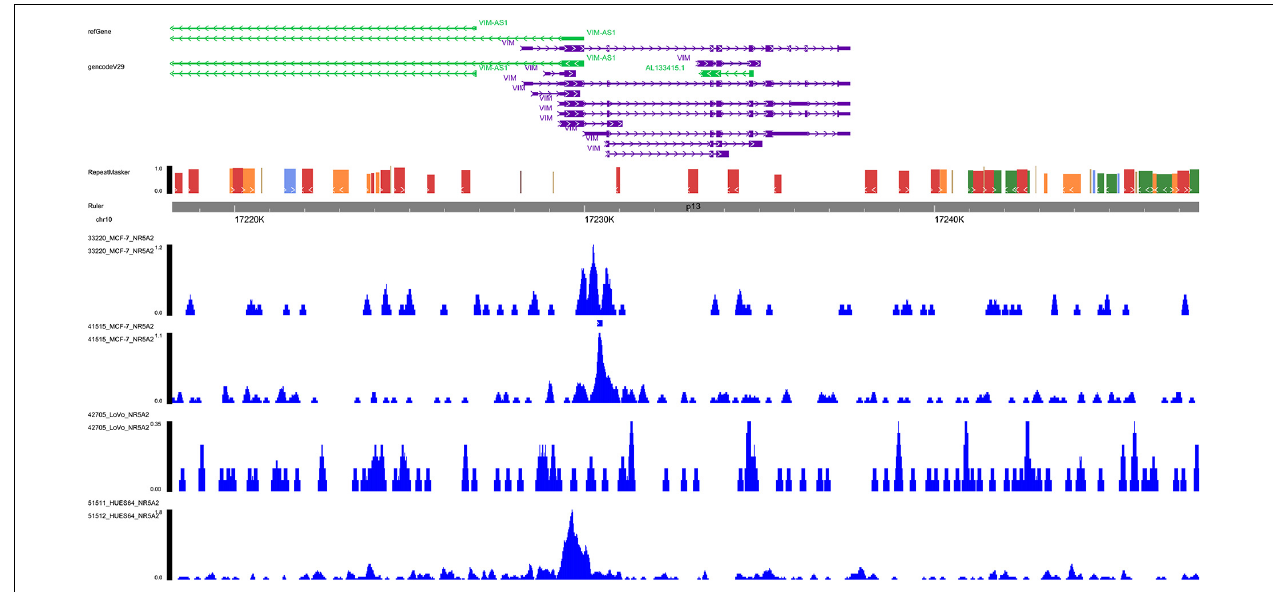
FIGURE 9 | ChIP-seq data validation. In NR5A2 ChIP-seq data, multiple binding peaks were found in VIM sequences. ChIP-seq, Chromatin immunoprecipitation sequence.